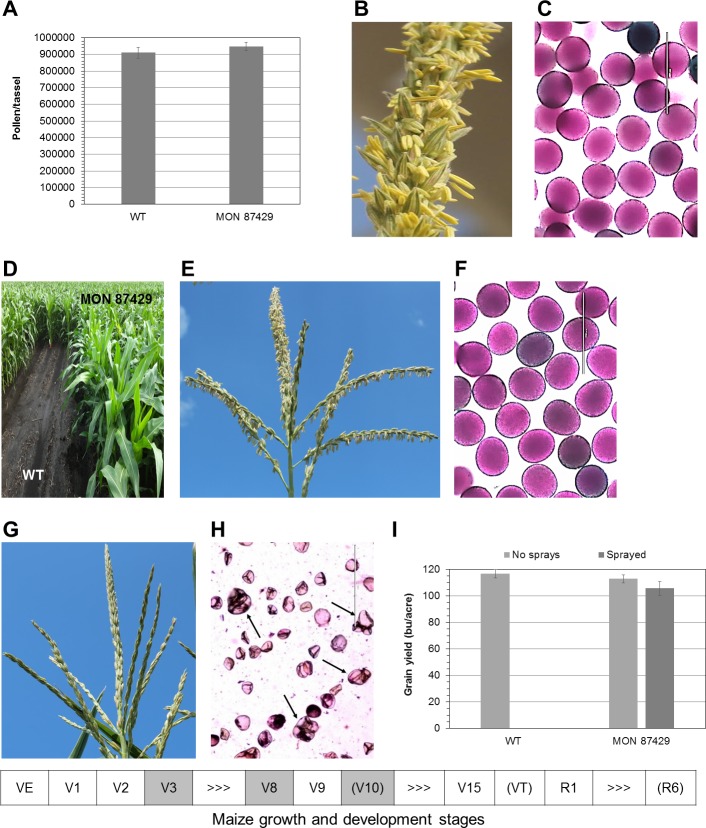
Inducible male sterility in plants containing MON 87429.(A) Pollen grain counts. No significant differences in pollen yields were observed between WT plants and plants containing MON 87429 when they were not treated with glyphosate. Whole tassels from 10 plants each were individually harvested in paper bags when pollen shed was observed throughout tassel branches. Pollen, mature or immature, were extracted and counted as described in the methods. (B) and (E) Tassel fertility of plants containing MON 87429. Anther extrusion was normal on the tassel from a plant that was not treated with glyphosate (B), or sprayed with 1.5 lbs ae/acre of glyphosate at stage V3 only for weed control (E), respectively. (C) and (F) Pollen viability of plants containing MON 87429. Pollen were viable when glyphosate was not sprayed (C), or applied at stage V3 (F), respectively. (D) Vegetative tolerance of plants containing MON 87429. No crop injury to the plants was observed after 1.5 lbs ae/acre of glyphosate was applied at stage V3 while WT plants were wiped out along with weeds. (G) and (H) Inducible male sterility of plants containing MON 87429. Tassels were sterile (G) and pollen were not viable (H) after 1.5 ae/acre glyphosate was sprayed at stage V3, followed by 0.75 lbs ae/acre each at V8 and V10. (I) Grain yields. The least significant difference (LSD) at 0.05 was 6.25 bu/acre between WT counterparts and plants containing MON 87429 that were not treated with glyphosate and 10.50 bu/acre between plants containing MON 87429 or NK603 that were treated with glyphosate at V3, V8 and followed by V10. The symbolic diagram shows maize growth and development stages. Grey shaded: glyphosate applied; in parentheses: data collected [at V10 for (D), VT for (A) to (C) and (E) to (H), and R6 for (I)]; >>>: V4 to V7, V11 to V14, or R2 to R5, respectively. Scale bars = 200 μm in (C) and (F) or 400 μm in (H). Arrows in (H) point to tetrads. Vn: leaf stages by number of leaves on the maize plant.